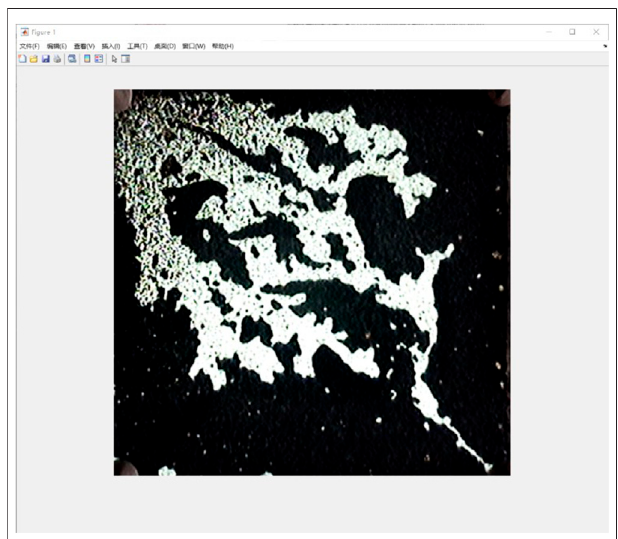
FIGURE 1 | Oil displacement outline of the visualization glass plate